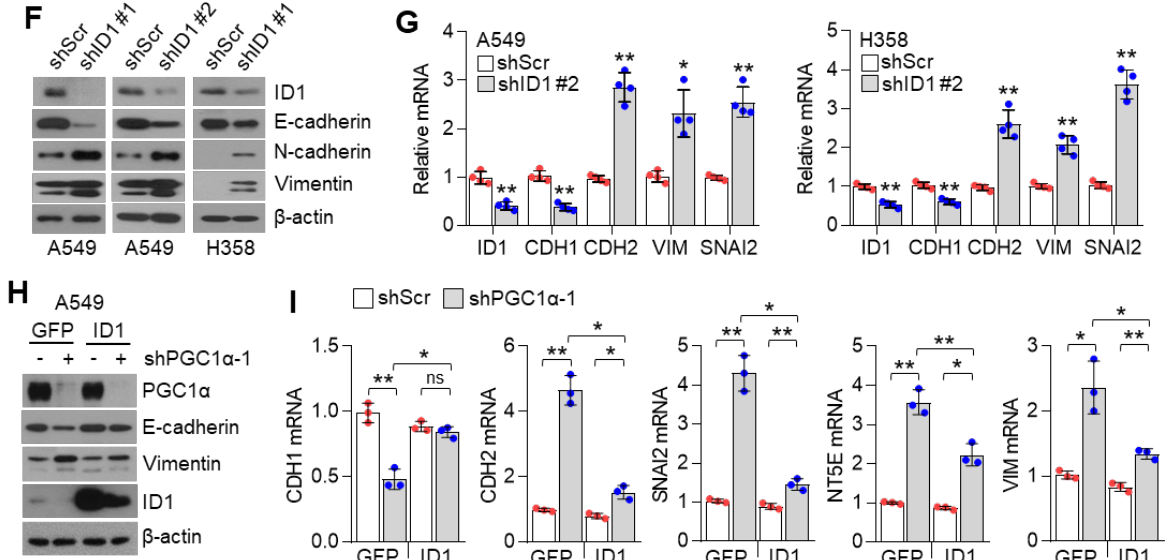
Figure 4. ID1 is a downstream target of PGC1 α and is linked to EMT in lung cancer cells. ( A ) qPCR of ID genes in the control or PGC1 α -silenced A549 and H358 cells ( n = 3). ( B ) Protein expression of ID1 and ID2 in the control and PGC1 α -silenced A549 and H358 cells. ( C ) Expression of the ID genes in GFP or PGC1 α stably expressing lung cancer cells ( n = 3). ( D ) ChIP for PGC1 α , H3K4-me3, and RNA pol II followed by ChIP-qPCR in A549 cells confirms a significant binding of PGC1 α at the ID1 proximal and distal promoter loci ( − 0.5 kb and − 4 kb) ( n = 3). ( E ) ID1 ( − 289 bp) and ID2 ( − 352 bp) promoter luciferase analysis. Luciferase vector (200 ng/mL) was transiently transfected into HEK293 cells with or without Flag-PGC1 α (50, 100, 200 ng/mL) ( n = 3). ( F ) Western blots of indicated proteins in the control or the ID1 knocked-down A549 and H358 cells. ( G ) Expression of the EMT genes in the control and ID1 silenced cells ( n = 3). ( H ) Western blots of indicated proteins in cells stably expressing GFP (pLX304-V5-GFP) or ID1 (pLX304-V5-ID1) in the control and the PGC1 α knocked-down A549 cells. ( I ) EMT genes expression in cells expressing GFP or ID1 in the control and the PGC1 α knocked-down A549 cells ( n = 3). ns, not significant; * p < 0.05 and ** p < 0.01 by Student’s t -test. The whole western blot images are showed in Figure